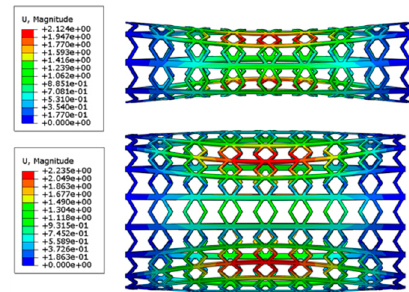
Figure 6. Buckling displacement amplitude of SMP stent with two different radiuses: 5.43 mm ( Nc = 8) and 10.65 mm ( Nc = 16).